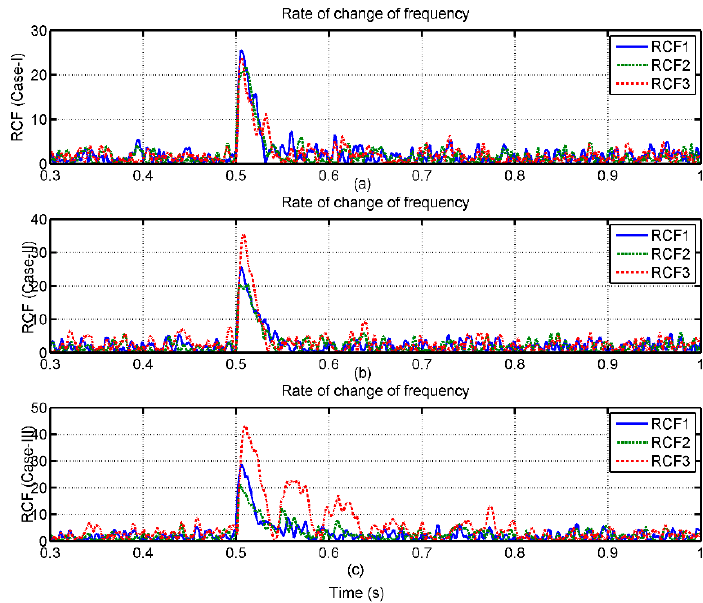
Figure 17. RCF analysis.